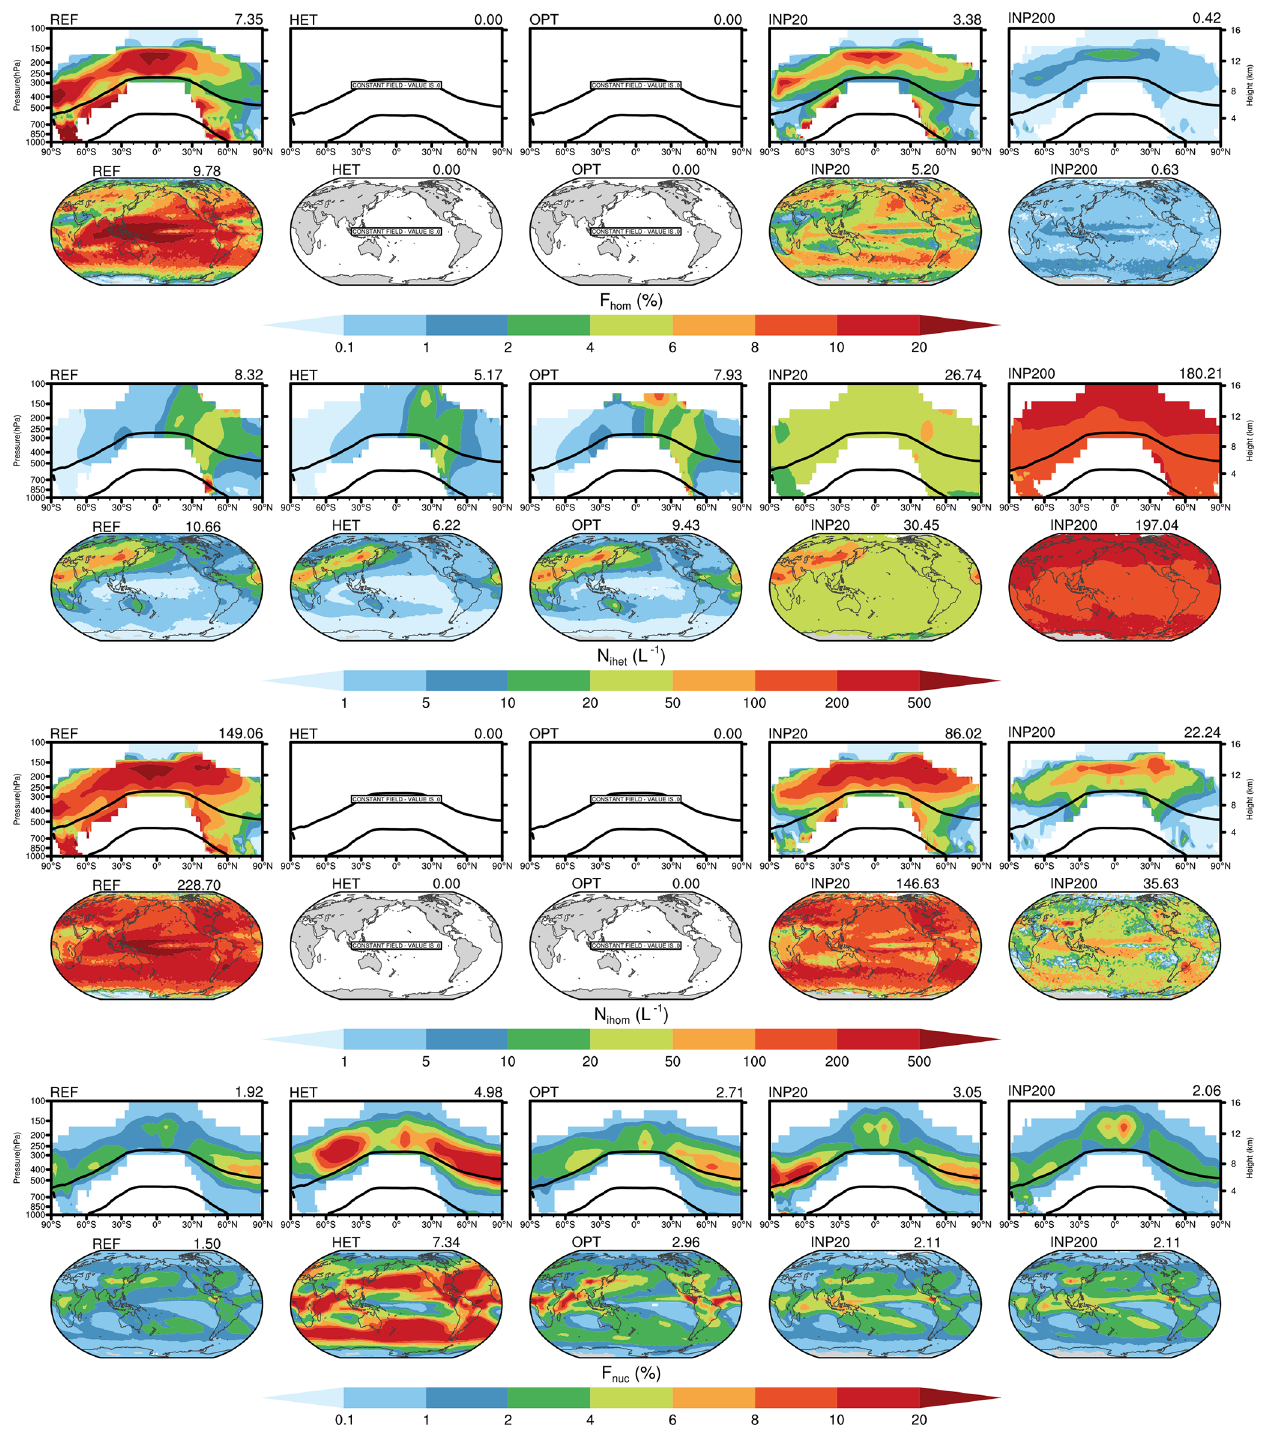
Figure 2. Annual zonal mean and 233hPa spatial distribution of the homogeneous nucleation contribution to cirrus formation ( F hom , first panel), averaged IC number concentration produced from heterogeneous freezing events ( N ihet , second panel) and from homogeneous freez- ing events ( N ihom , third panel), and ice nucleation occurrence frequency ( F nuc , last panel). Experimental names are shown in the upper left corner, and global mean values are shown in the upper right corner. The two black lines are 0 and − 37 ◦ C isotherms. The results are sampled from model grids where F nuc is greater than